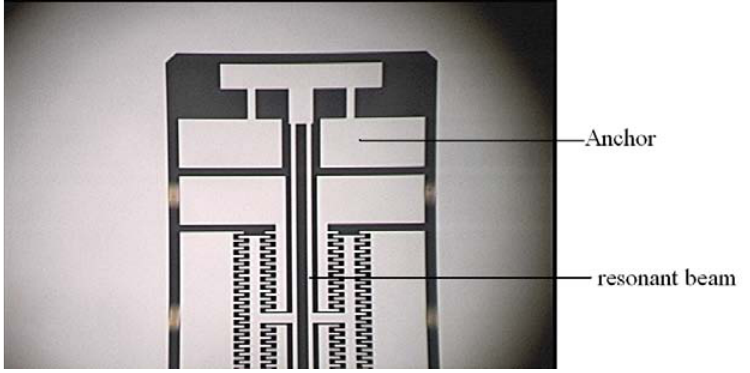
Figure 15. The local structure of the improved micromechanical silicon resonant accelerometer under the 3D video microscope.